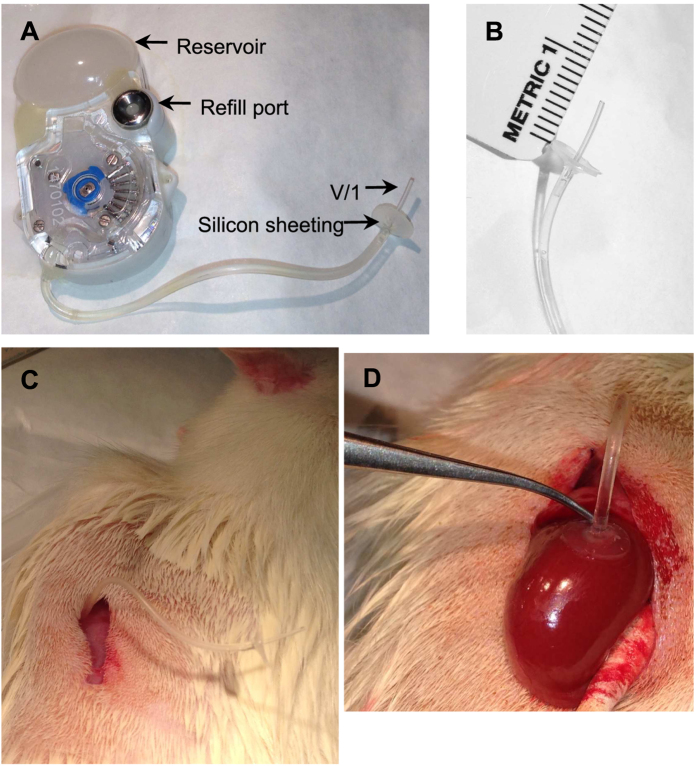
Preparation and insertion of implantable, peristaltic pumps (iPRECIO®) into rats for the study.(A) The reservoir of the sterile pump is filled through the port, and the catheter is fitted with a silicon sheet and V/1 tubing. (B) The V/1 tubing is 8 mm in length. (C) The pump fits in a subcutaneous pocket on the dorsal side of the rat. (D) the V/1 tubing is inserted into the kidney and adhered.